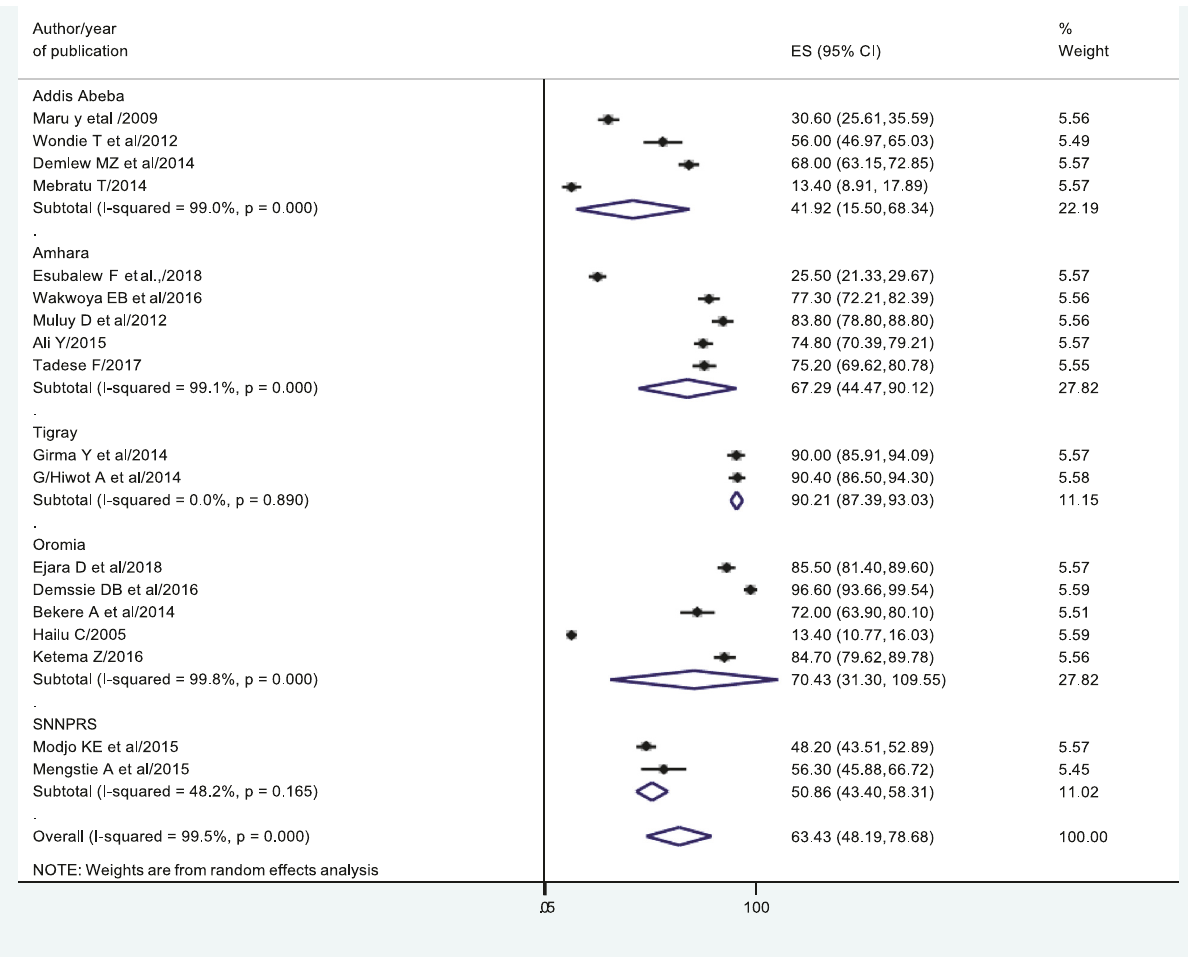
Figure 3: Forest plot of the prevalence EBF with 95% CI. The midpoint and the length of each segment showed the prevalence and 95% CI, respectively. The diamond shape showed the combined prevalence of each